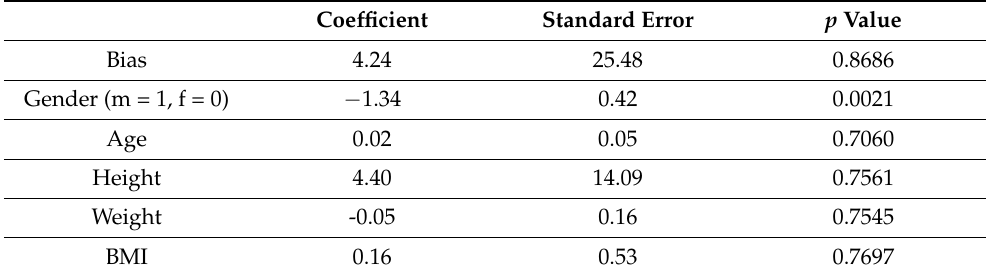
Table 2. Multiple linear regression model of AT stiffness in professional